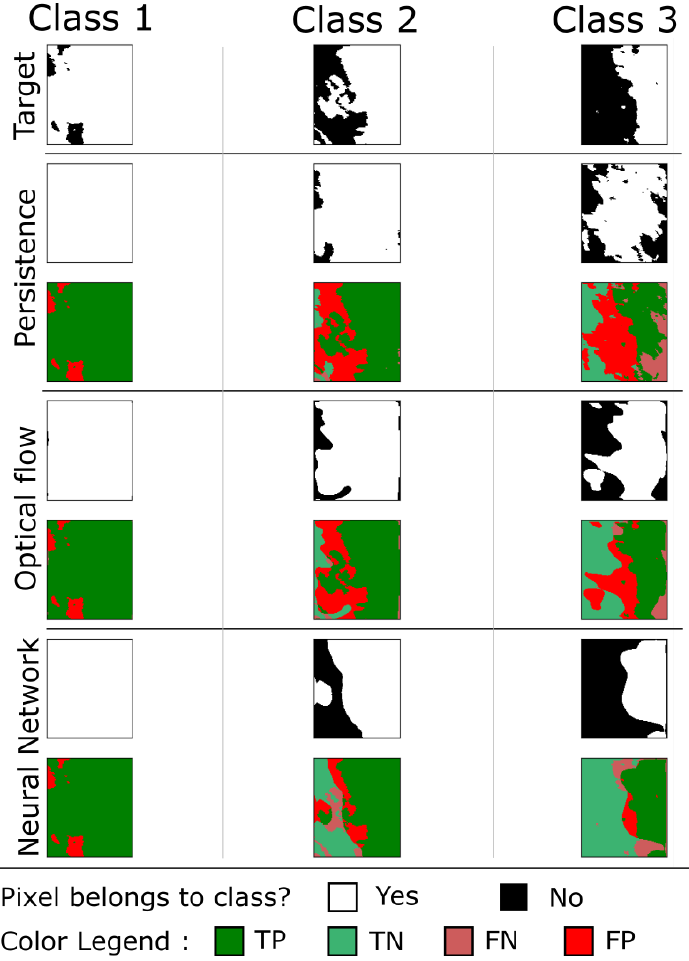
Figure 9. For caption details see Figure 8. The neural network tends to smooth the rain cells and its forecast contrary to the target which is quite